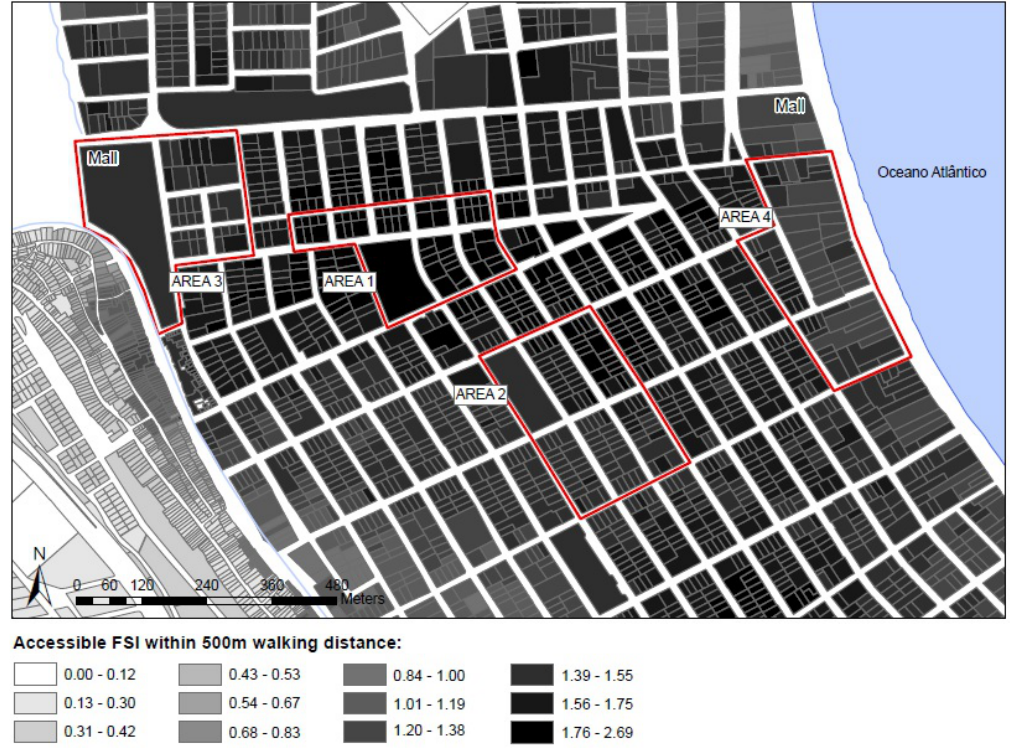
Figure 1. Map of a section of Manaíra district (João Pessoa, Brazil), with testing areas marked, showing accessible Floor Space Index (FSI) within 500 m walking distance.